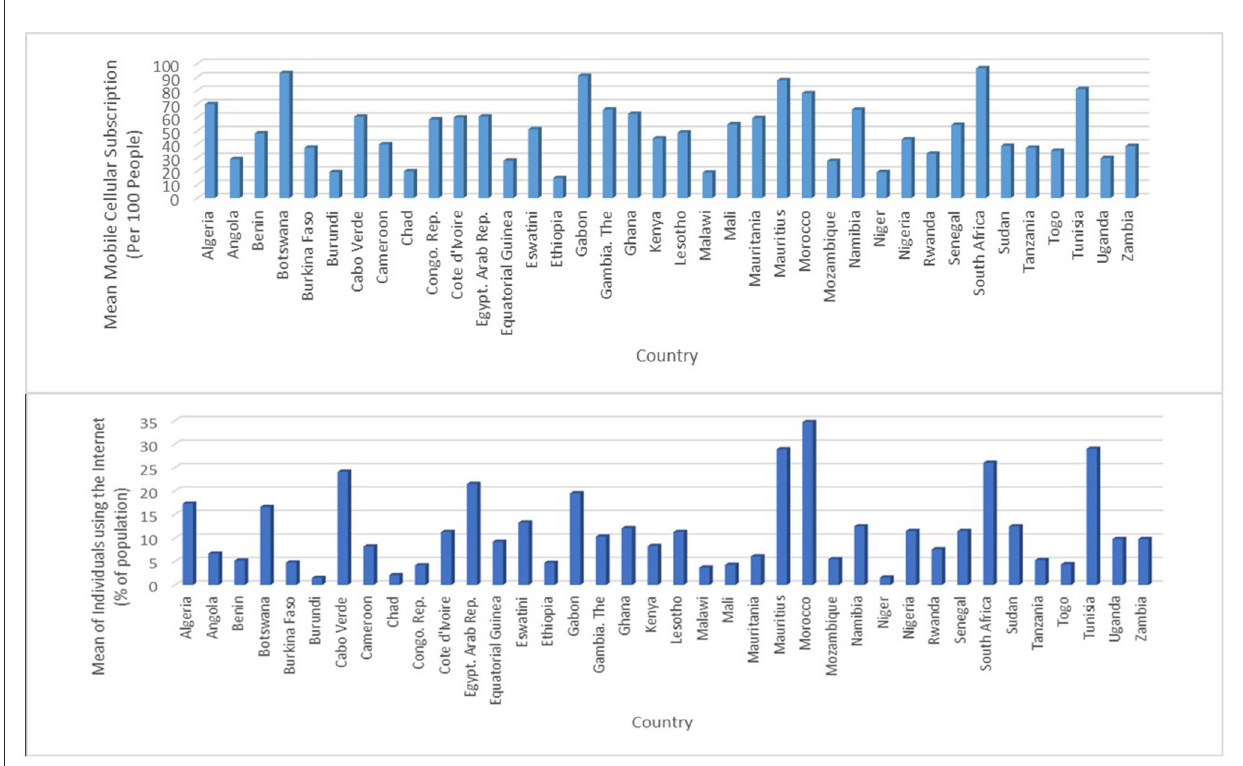
FIGURE2 Average mobile phone subscription and internet access by country (2000–2018). Source: Data for the Graph was sourced from ITU.